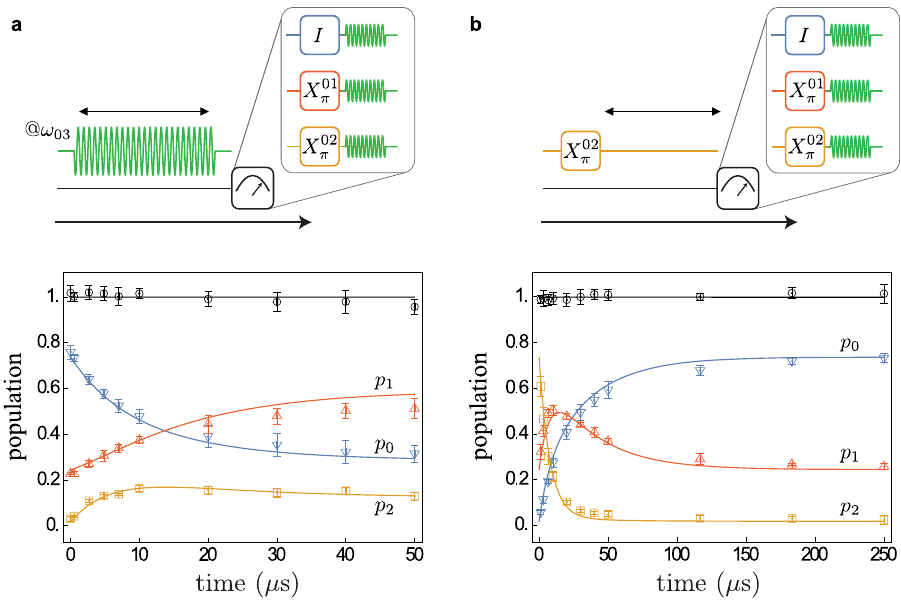
Fig. 3 Transient dynamics of fl uorescence. a Time-domain evolution of populations p 0 (down blue triangles), p 1 (up red triangles), and p 2 (yellow squares) induced by the cycling of the readout transition (pulse sequence on top). Note that p 0 decays approximately exponentially in time with a characteristic time scale τ cyc = 9.6 μ s , after which the population is transferred from state 0 j i to states 1 j i and 2 j i . The black circles indicate p 0 + p 1 + p 2 and the error bars represent the standard deviation coming from the repetition of the measurements over two days. b Free evolution of populations starting predominantly from state 2 j i (pulse sequence on top). The data in both ( a ) and ( b ) is adequately explained by an optical pumping model (solid lines) (see text) where the dominant error mechanism is a non-radiative decay due to dielectric